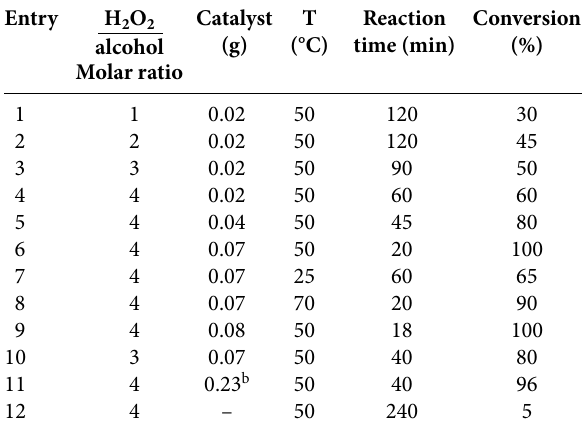
Tabari et al.: Magnetic Nanoparticles Linked ...